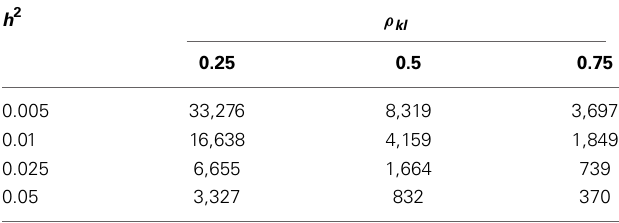
Table 10 | Simulation evaluations of Equation (11) and comparison between the HE regression and the mixed linear model